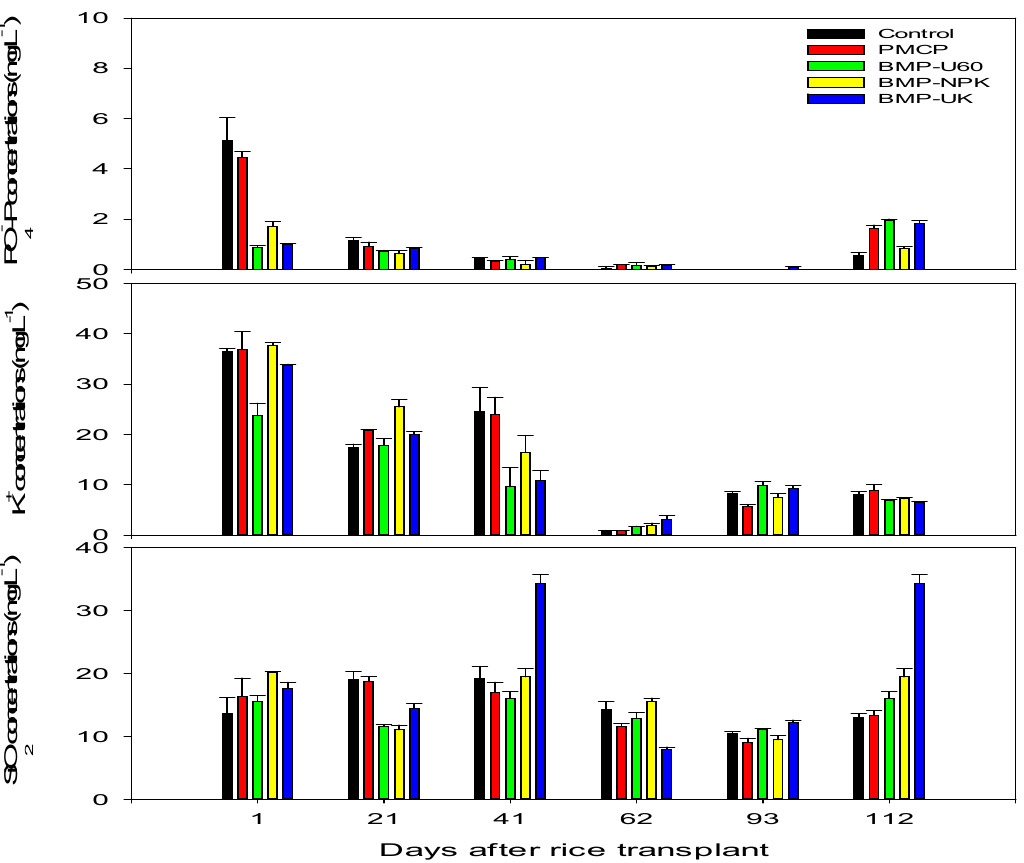
Figure 3. Effects of different treatments on PO 4 − –P, K + and SiO 2 concentrations in surface paddy water during rice cultivation. The values displayed are averages of triplicate samples with standard deviation.